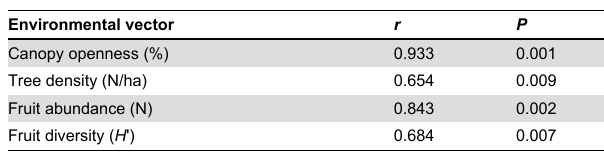
Table 6. Significant structural vectors in the non-metric multidimensional scaling ordination using Bray-Curtis dissimilarity performed on frugivorous bat species abundance for each forest type site, showing correlation coefficient (r) and significance ( P ) based on 999